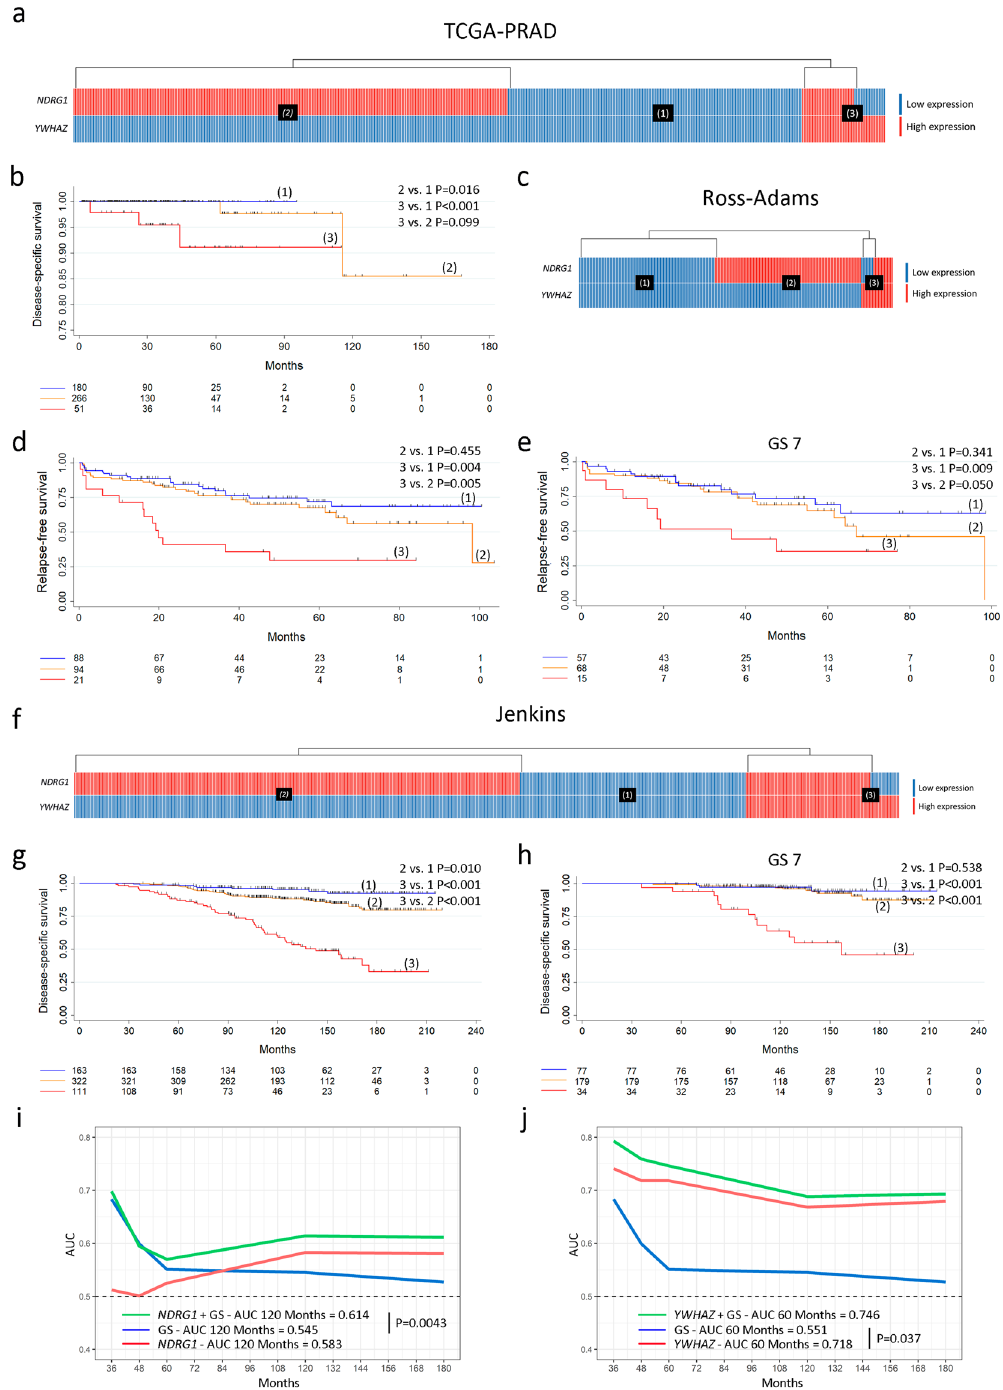
Fig. 5 Validation of YWHAZ and NDRG1 as risk strati fi cation genes in PCa patients ( TCGA-PRAD , n = 499; Ross-Adams , GSE70770, n = 206; and Jenkins , GSE10645, n = 596). a , c , f Heatmaps depicting low (blue) or high (red) NDRG1 and YWHAZ gene expression for patients with PCa according to the TCGA-PRAD ( a ), Ross-Adams ( c ), and Jenkins ( f ) data sets. Patient subgroups are presented in black boxes: low YWHAZ and NDRG1 expression (1), high NDRG1 expression (2), and high YWHAZ expression (3). b , d , g Kaplan – Meier curves for DSS ( TCGA-PRAD ) ( b ), RFS ( Ross-Adams ) ( d ), and DSS ( Jenkins ) ( g ), for PCa patients segregated based on gene expression levels for YWHAZ and NDRG1 . e , h Kaplan – Meier curves for RFS ( Ross-Adams ) ( e ) and DSS ( Jenkins ) ( h ), for PCa patients segregated based on gene expression levels for YWHAZ and NDRG1 in GS 7. P = pairwise log-rank P -values. i , j Time- dependent AUC curves measured from 36 to 180 months re fl ecting the performance of GS (blue), NDRG1 ( i ) or YWHAZ ( j ) (red), and NDRG1 + GS ( i ) or YWHAZ + GS ( j ) (green) in PCa patients. AUC = area under the ROC curve. P = P -value for DeLong ’ s test for two ROC curves. GS = Gleason score. All comparisons consider low expression patients as the reference group. Statistical signi fi cance was set at P ≤ 0.05.